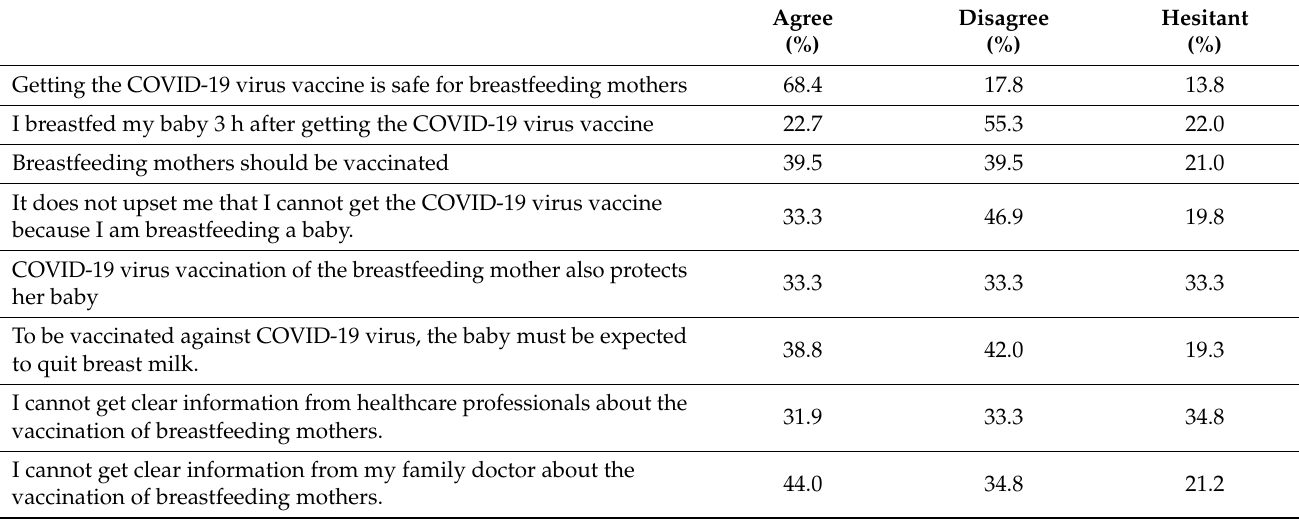
Table 2. Knowledge and Attitudes of 405 Mothers Participating in the Study About COVID-19 Virus Vaccination During Breastfeeding.